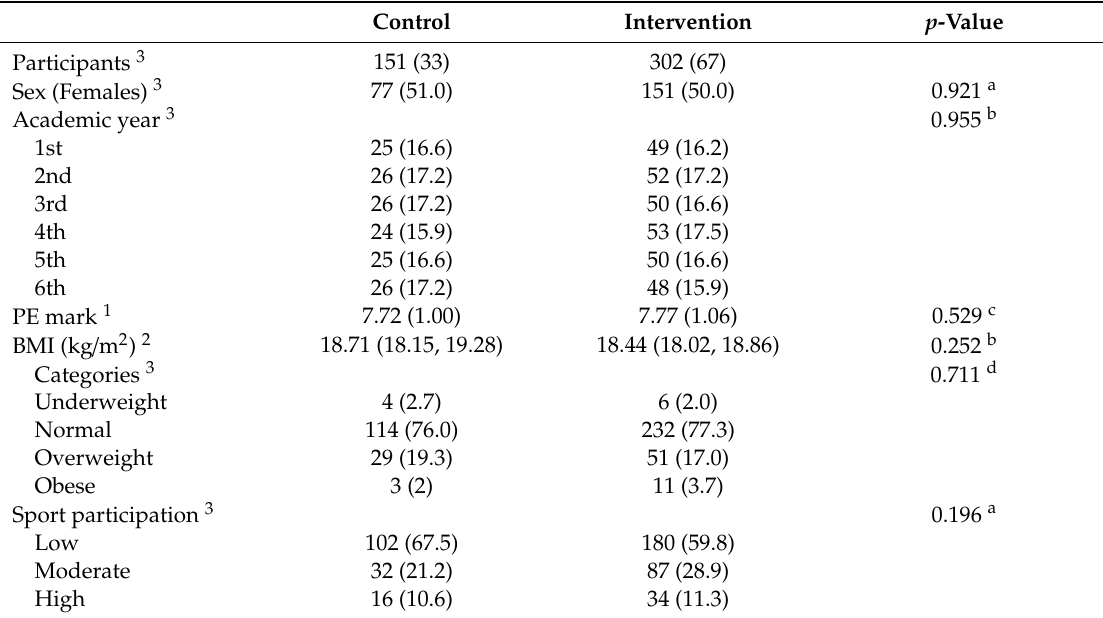
Table 1. Baseline characteristics of the two